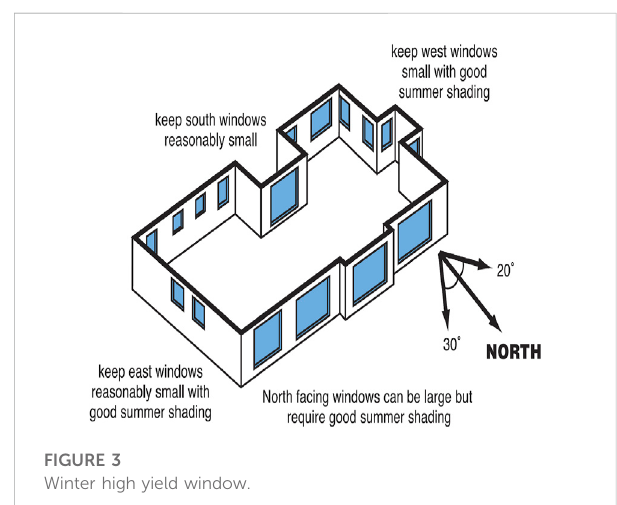
FIGURE 3 Winter high yield